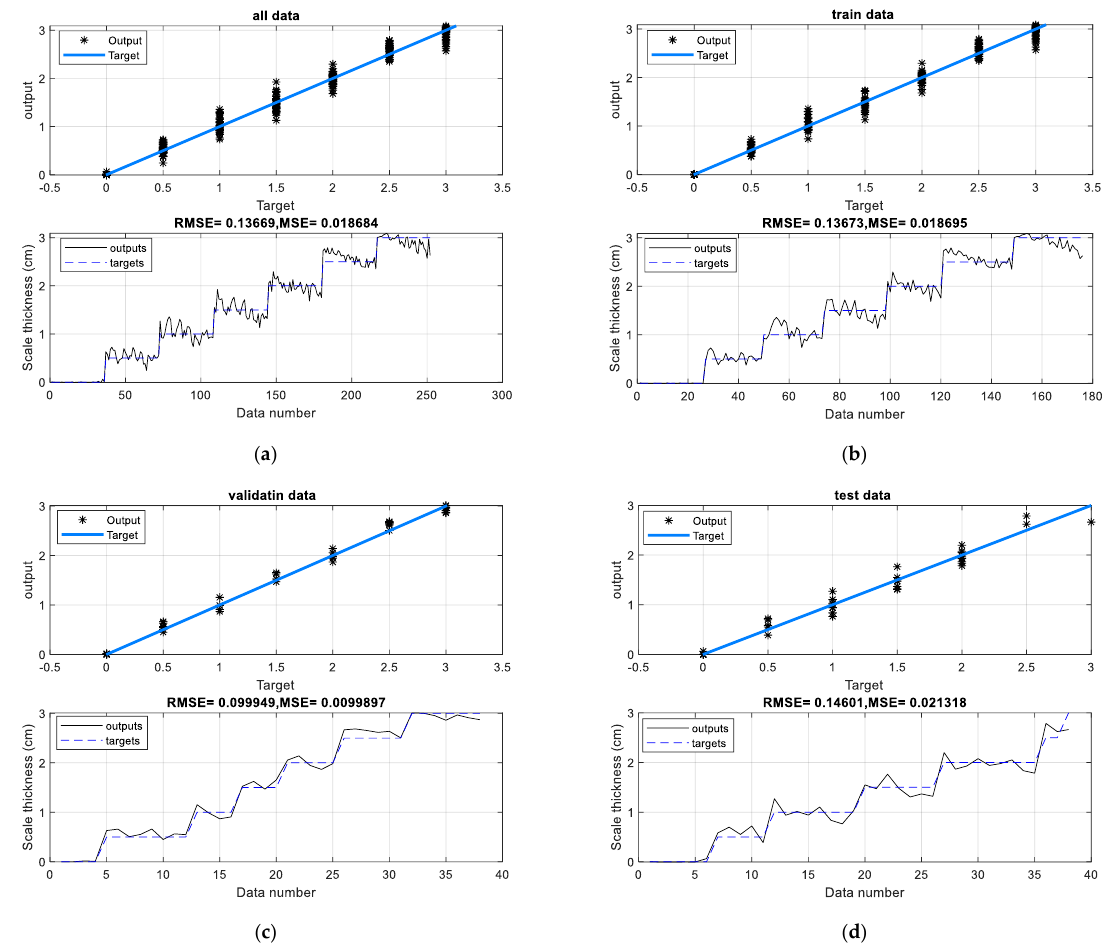
Figure 5. Regression and fit plots for: ( a ) all data, ( b ) training data, ( c ) validation data, and ( d ) test data. Table 2. A comparison of the accuracy of the proposed detection system and previous